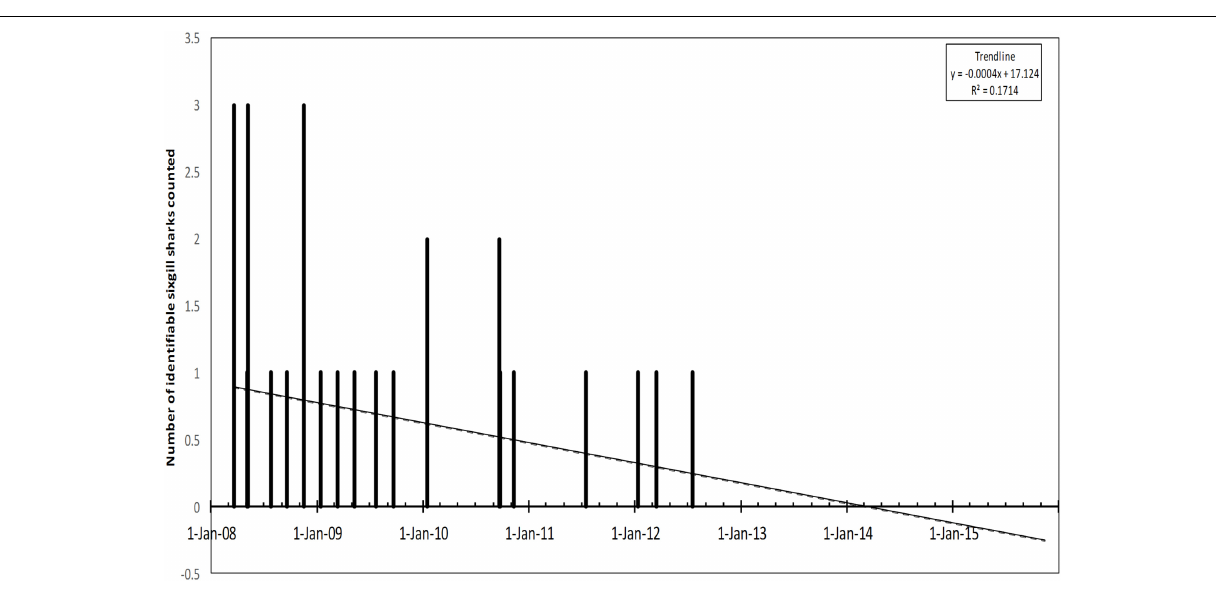
FIGURE 2 | Daily sightings during research events of Sixgill Sharks underneath the Seattle Aquarium between 2008 and